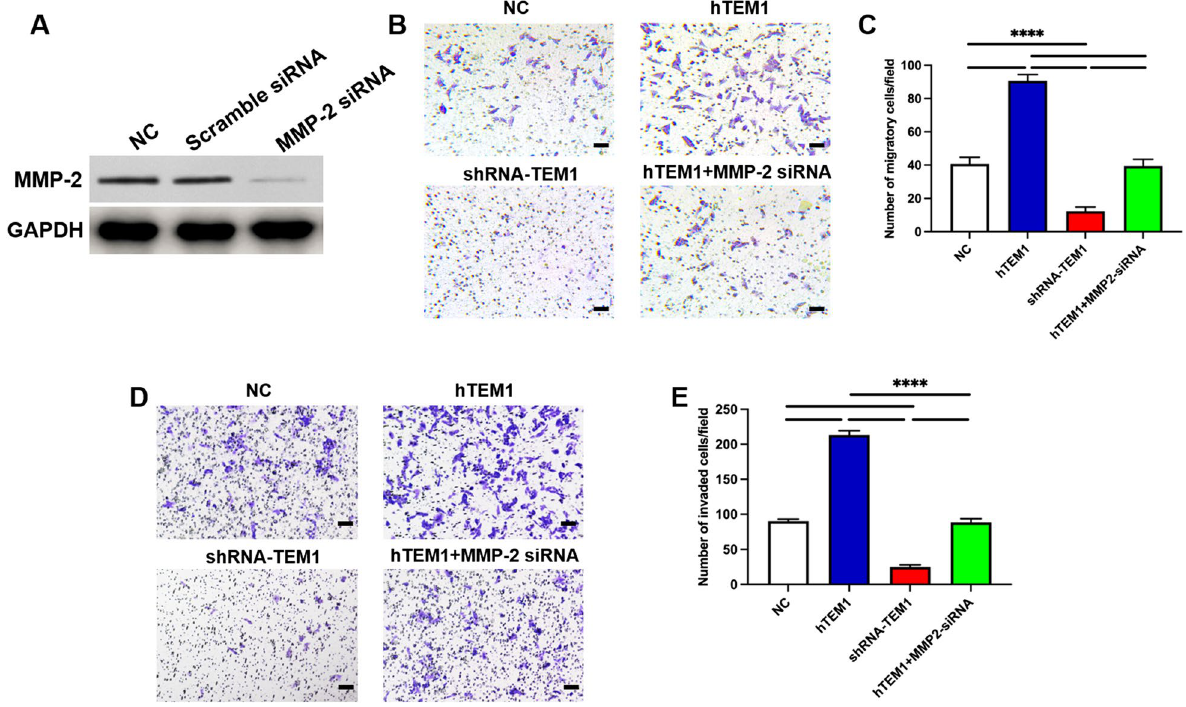
Fig. 3 TEM1 regulating MES-SA cell migration and invasion via MMP-2. Western blotting results confirming knock-down of MMP-2 protein by MMP-2 siRNA A . Both cell migration ability B and C and invasion ability D and E were enhanced in hTEM1 cells and inhibited in shRNA- TEM1 treated cells. And hTEM1 MES-SA cells transfected with MMP-2 siRNA (hTEM1 + MMP-2 siRNA) showed comparable invasion and migration ability to NC group. ****, P < 0.0001. All assays were replicated three times in triplicates. Magnification, 100X; bar scale, 100